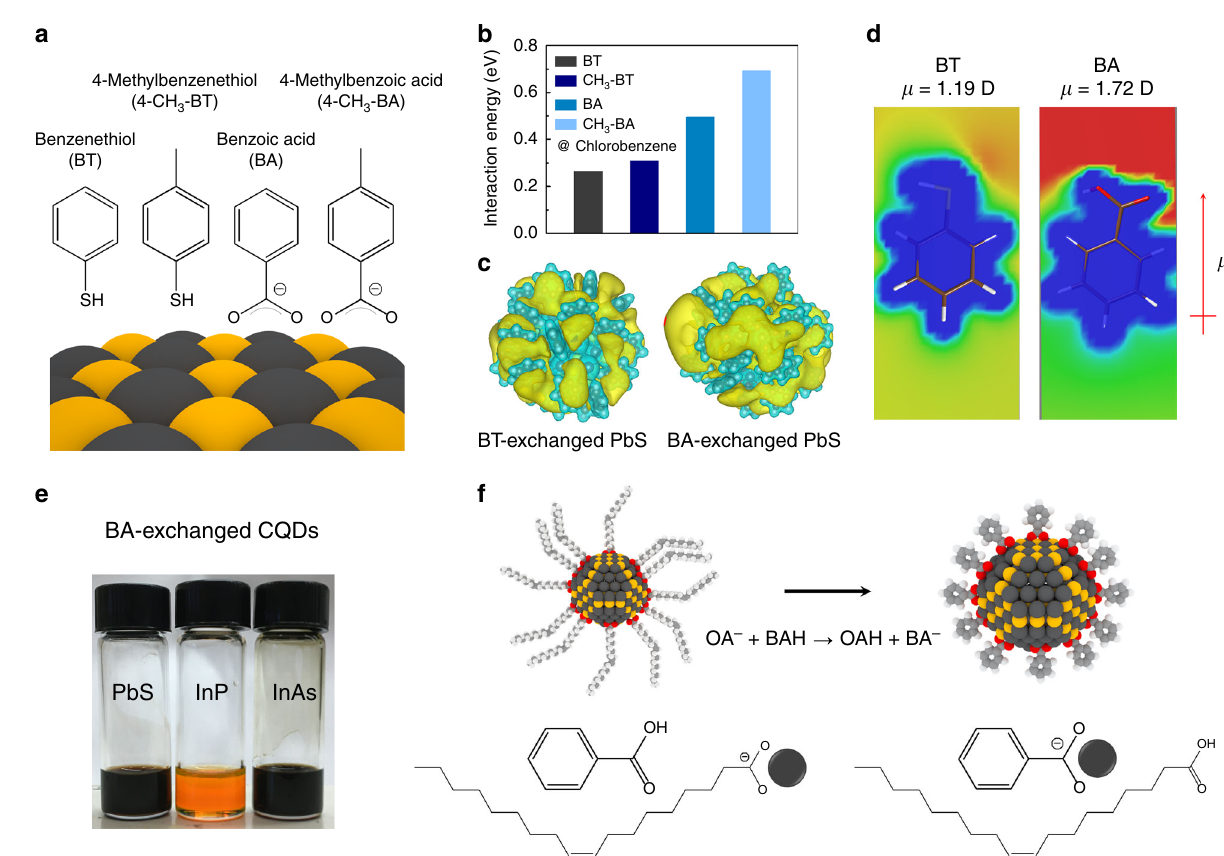
Fig. 1 Orthogonal CQD inks. a Chemical structure of aromatic ligands. b Interaction energies of four different ligand-exchanged CQDs with chlorobenzene. c Electrostatic potentials of entire CQDs capped with BT and BA. d Electrostatic potentials of isolated BT and BA ligands. e Photograph showing the dispersibility of the BA-exchanged CQDs (PbS, InP/ZnSe/ZnS, and InAs) in chlorobenzene. f Schematic illustrations of the ligand exchange